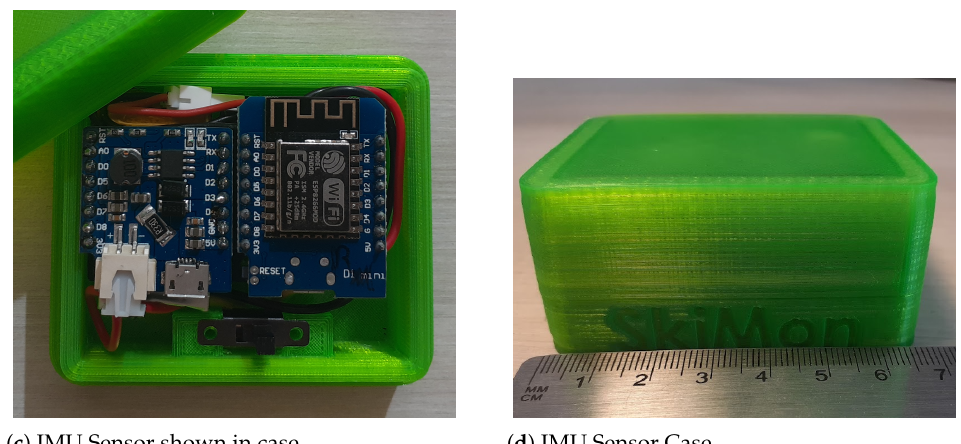
Figure 3. Inertial Measurement Unit WBAN ski motion sensor parts.